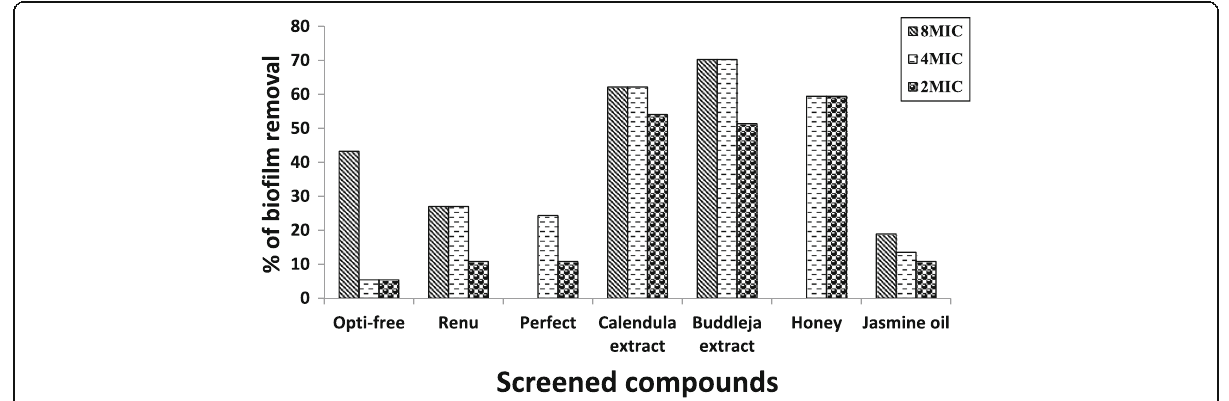
Fig. 2 Percentage of biofilm removal by screened -care solutions and natural